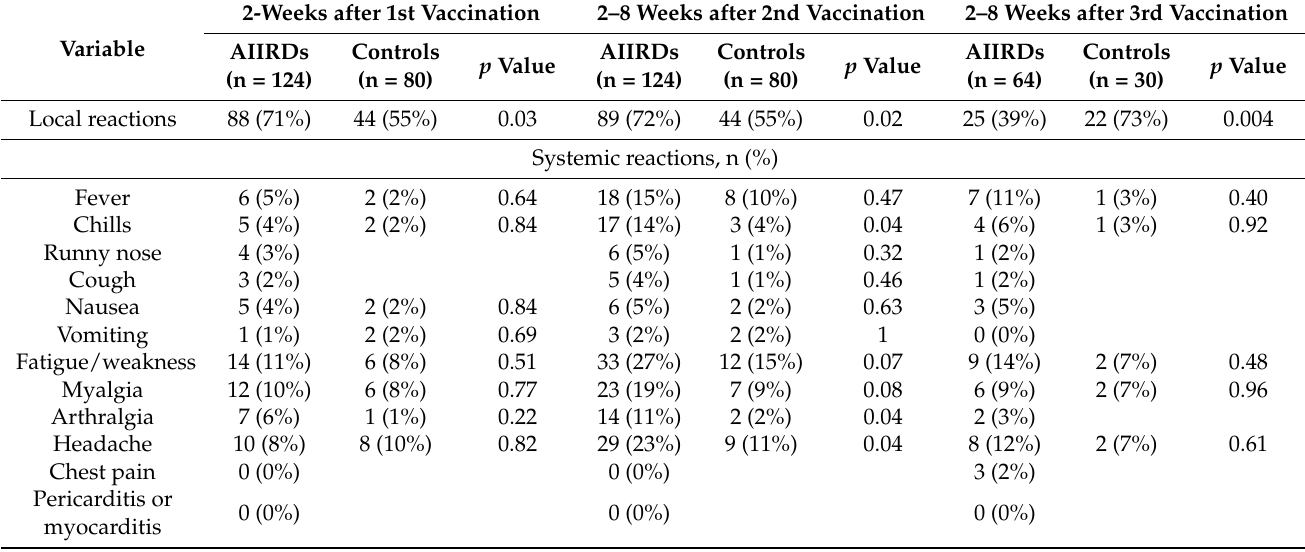
Table 2. Adverse events following BNT162b2 mRNA COVID-19 vaccine among adolescents with AIIRDs and